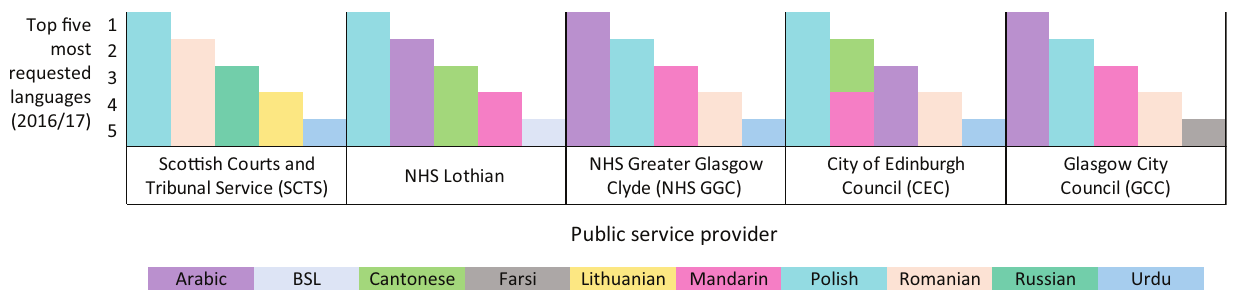
Figure 1. Language demand recorded by the selected service providers. Sources: ITS Manager (personal communication), Jaouen (personal communication), Operations Manager (personal communication, May 17, 2019), Stewart (personal com- munication), Zduniak (personal communication) and McKelvey